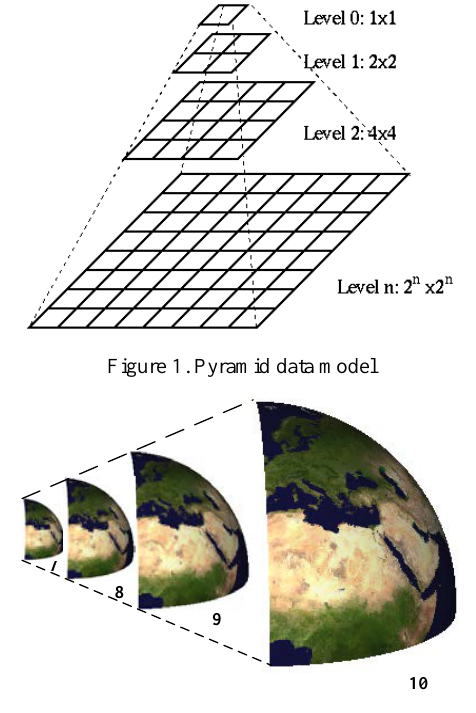
Figure 2. Multi-layers SDOG-ESSG image representation Algorithm 1 Generation of SDOG-ESSG children codes